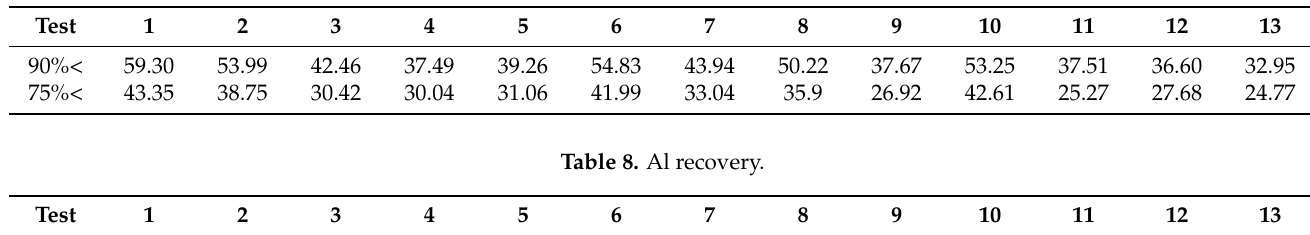
Table 7. Results from particle size distribution measurements ( µ m).